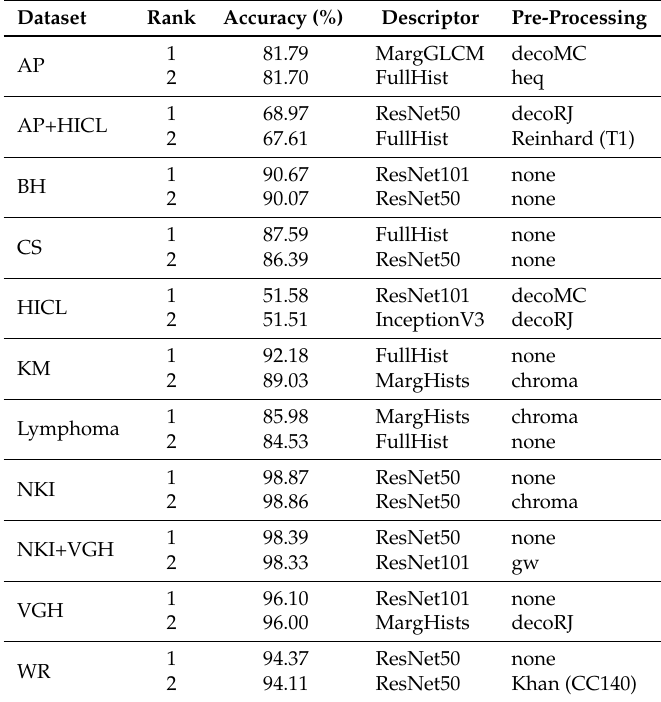
Table 2. Best (rank = 1) and second-best (rank = 2) combinations color pre-processing/image descriptor by dataset. Figures indicate accuracy, also reflected in the ball size and color (blue = low, brown = high). Values are filtered on f =